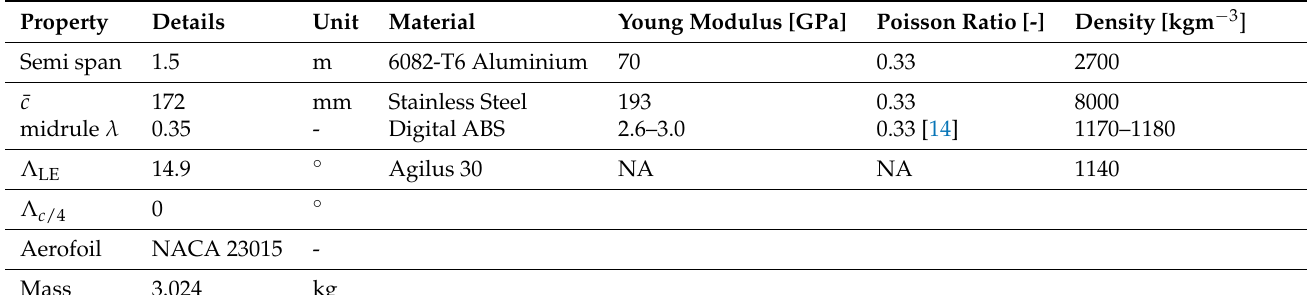
Figure 2. XB-2 wing top view. Table 1. Materials and physical properties.